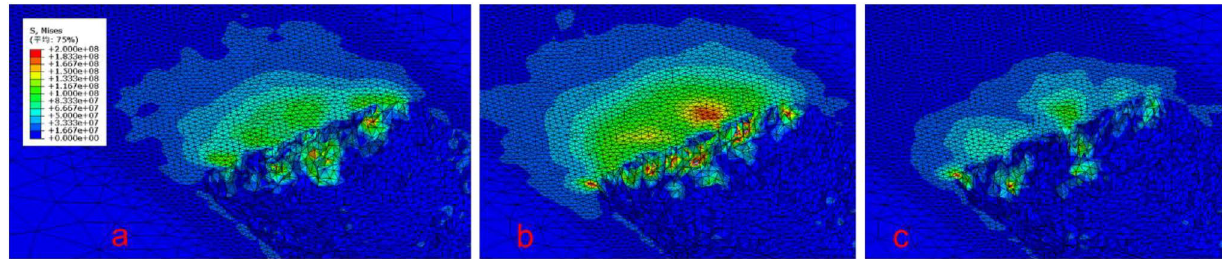
Fig. 16 Stress distribution in the rock section under the action of the flat cutter